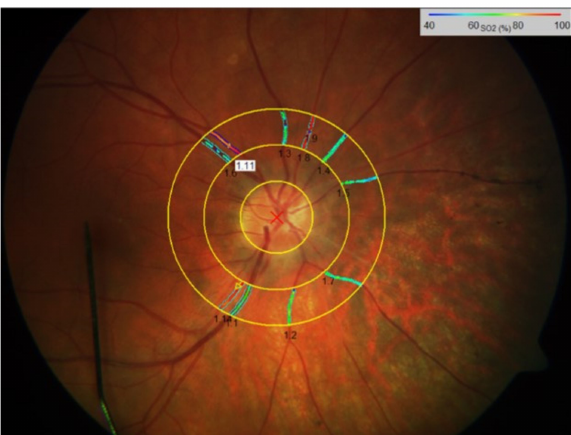
Figure 1. A peripapillary vessel map of the retinal vessel image of a patient with retinitis pigmentosa. Retinal vessel diameters in retinal arterioles (D-A, µ m) and retinal venules (D-V, µ m), were measured within the peripapillary annulus in control subjects as well as in RP patients. The corresponding retinal vessel oxygen saturation values (A-SO 2 , V-SO 2 and A-V SO 2 ) were calculated, as well. The colors in the oximetry image indicate the relative oxygen saturation (%) in retinal vessels as quantified in the scale bar. Note the increased A-SO 2 compared to V-SO 2